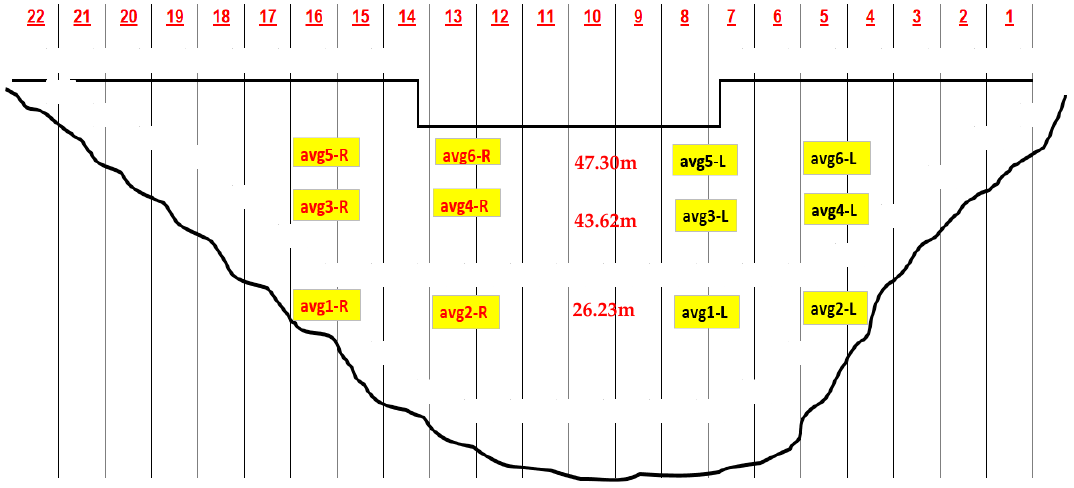
Figure 5. Wall thermometers measuring water temperature.